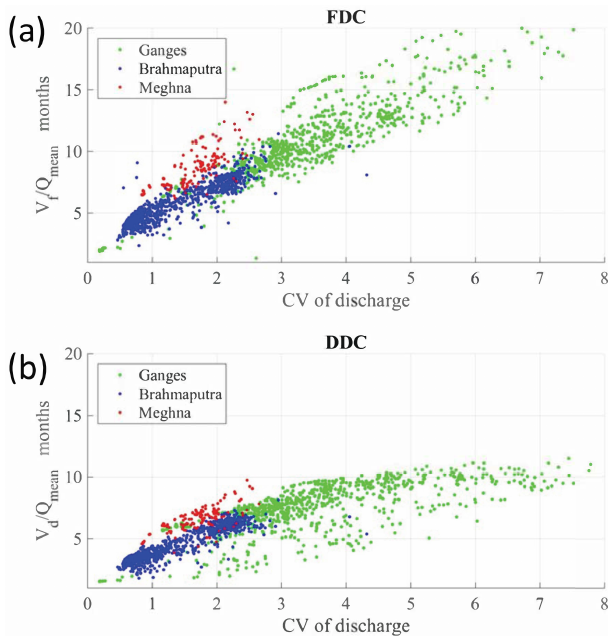
Figure 15. Relation between necessary storage in months and CV of daily discharge of a 5-year return period for (a) flood and (b) drought management at all grid points of the GBM basin.